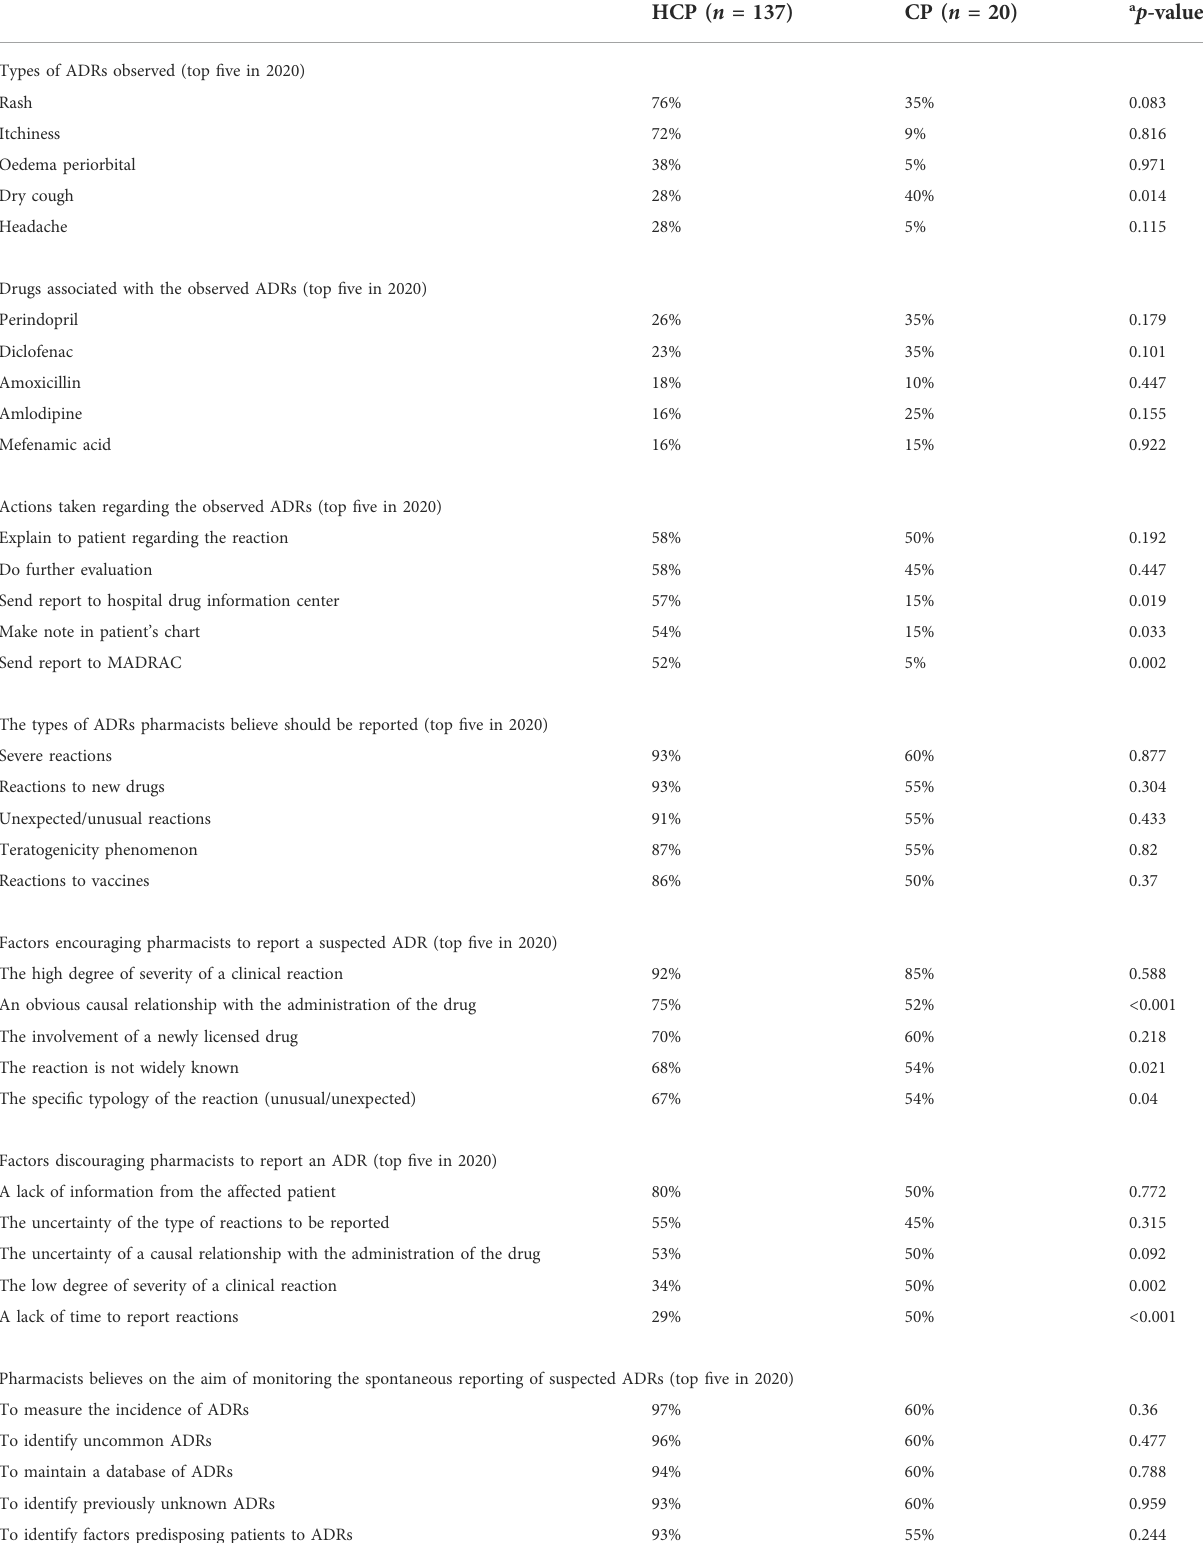
TABLE 3 Comparison between hospital/health clinic pharmacists (HCPs) and community pharmacists (CPs) in